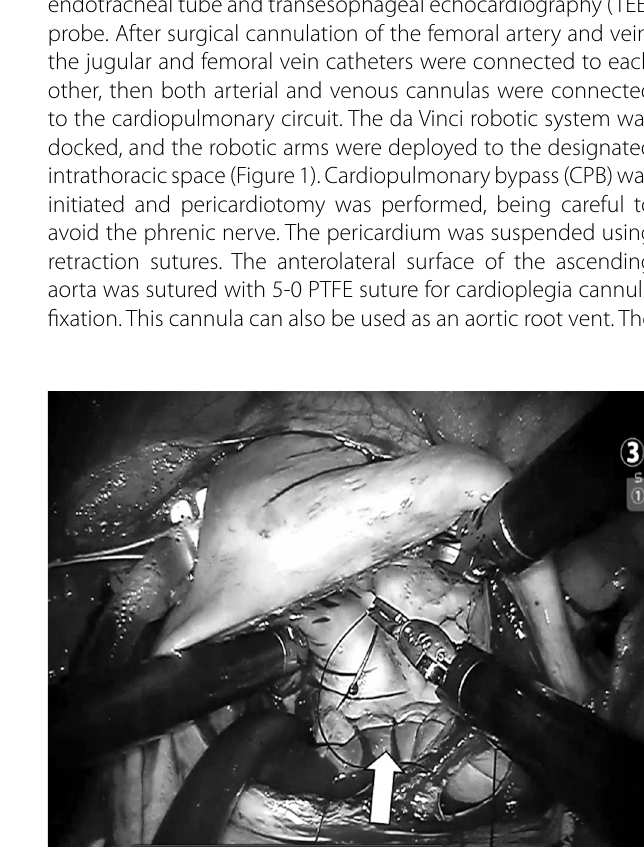
Fig. 1 - Robotic left atrial reduction